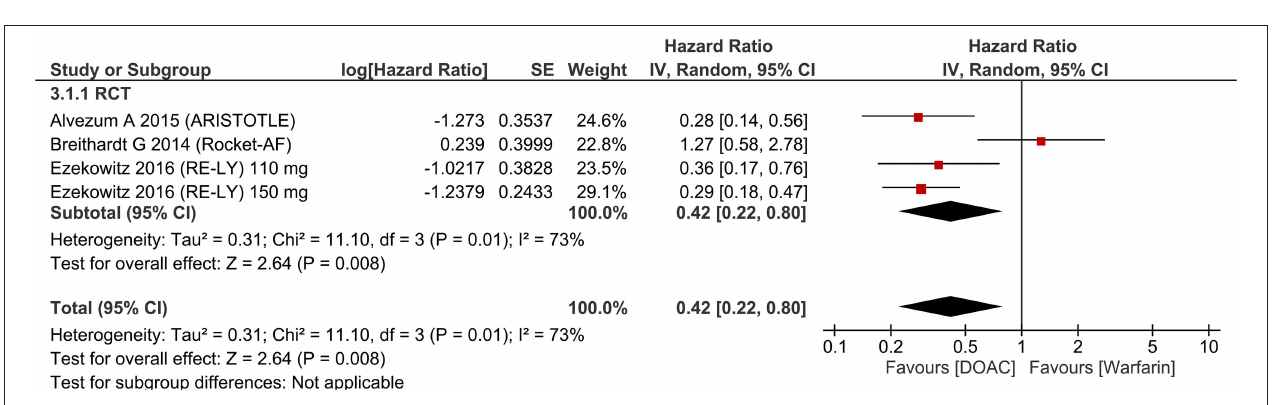
FIGURE 3 | Major bleeding.